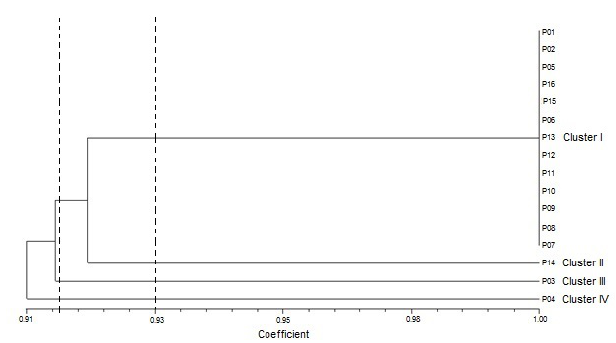
Figure 4. SDS-PAGE of P. biglobosa seed total proteins. A) Accessions NH/2016/P01 to NH/2016/08; B) Accessions NH/2016/P09 to NH/2016/P16. M stands for protein size marker. * indicates the missing 24 kDa band in NH/2016/P04.